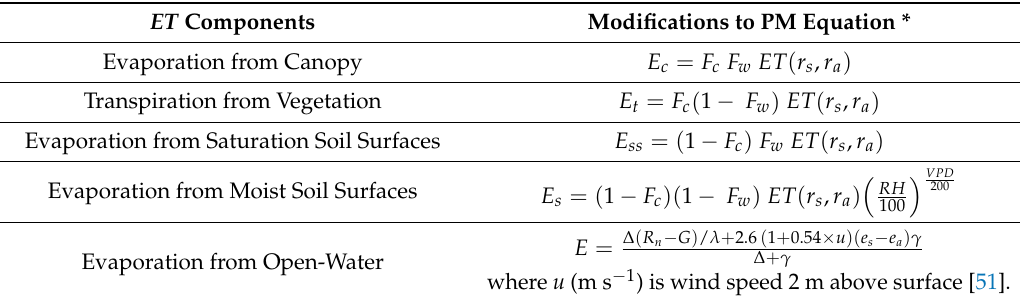
Table 2. Summary of ET component